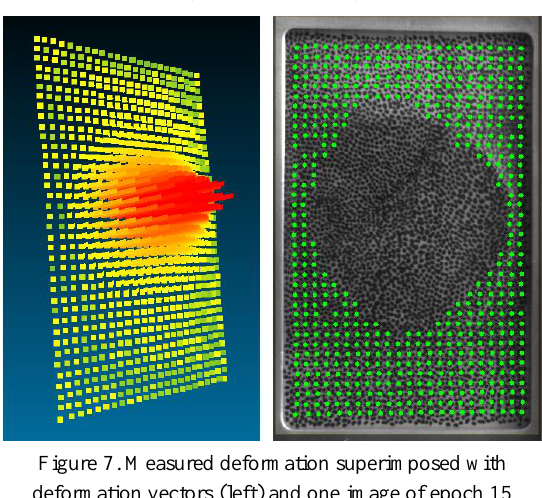
Figure 7. Measured deformation superimposed with deformation vectors (left) and one image of epoch 15 superimposed with congruent points